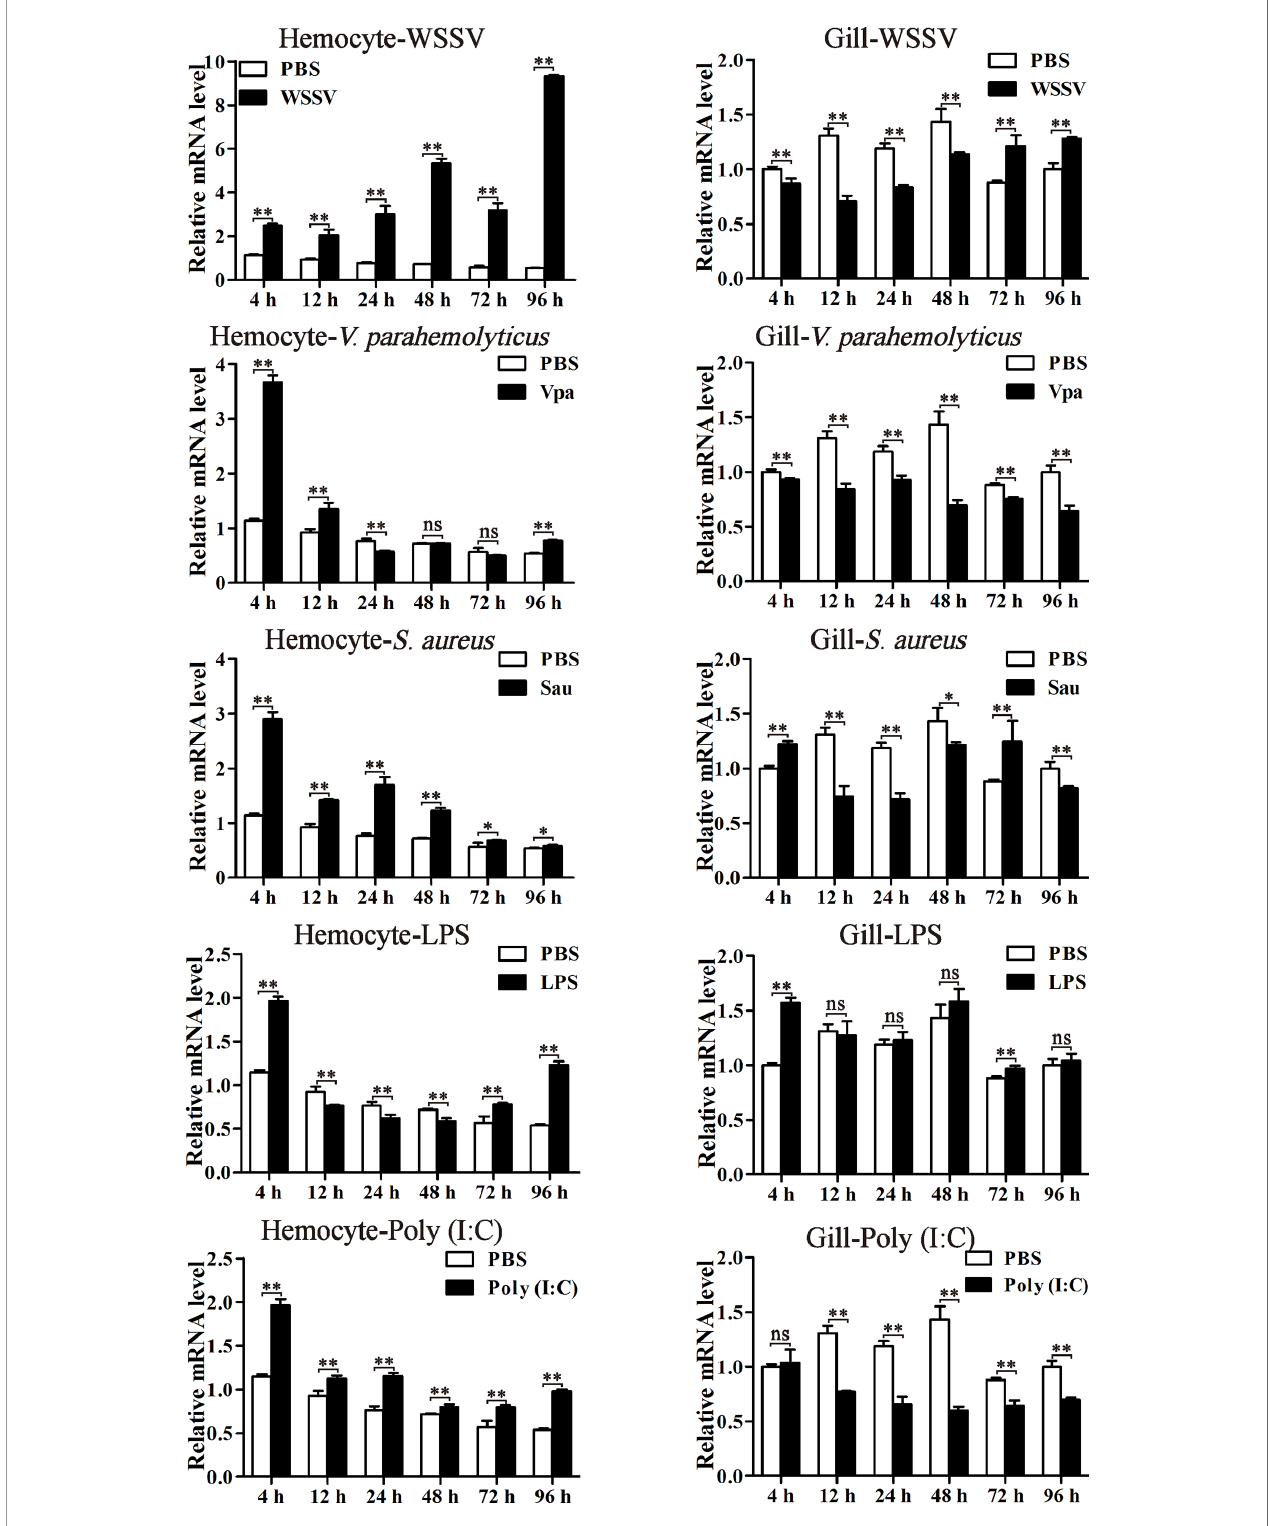
FIGURE 4 | The expression pro fi les of LvPTPN6 after immune stimulation. The expression of LvPTPN6 in hemocyte and gill of WSSV-, V. parahaemolyticus - (Vpa), S. aureus - (Sau), LPS-, and Poly(I:C)-challenged shrimps were detected using qRT-PCR. In each panel, the value of PBS group at 4 h was set as the baseline (1.0). Each bar represents the mean ± SD ( n = 4), ** p < 0.01, * p < 0.05, and ns > 0.05 by two-tailed unpaired Student ’ s t